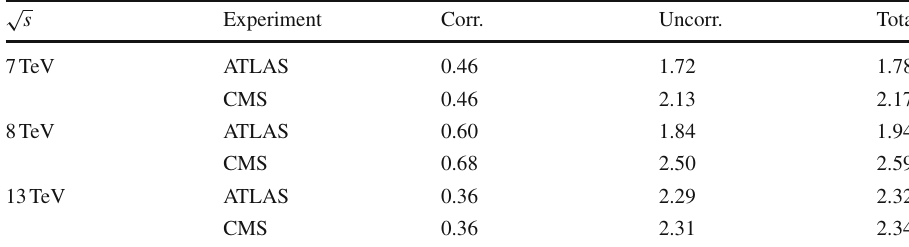
√ s Experiment Corr.